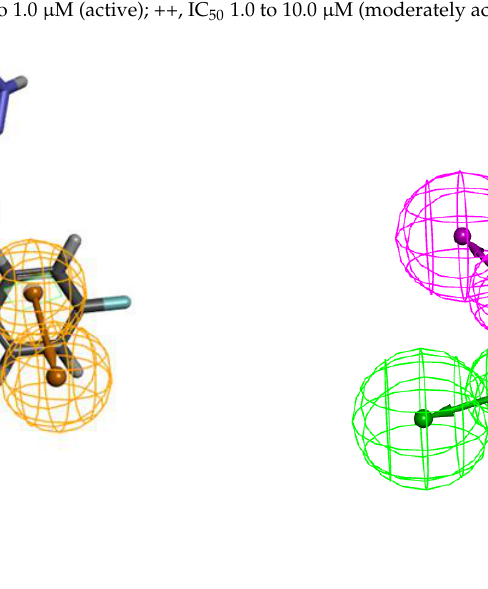
Figure 2. Pharmacophore mapping of the most active and less active compounds in the training set. ( A ) Hypo1 mapped on to the most active compound T25 ; ( B ) Hypo1 mapped on to the least active compound T05 .